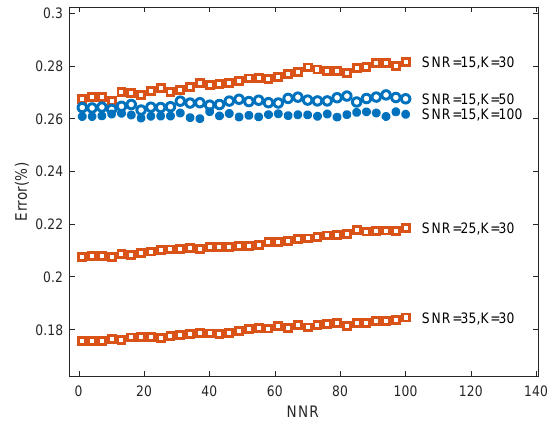
Figure 5. The errors e I and e E as a function of K for NNR = 10.